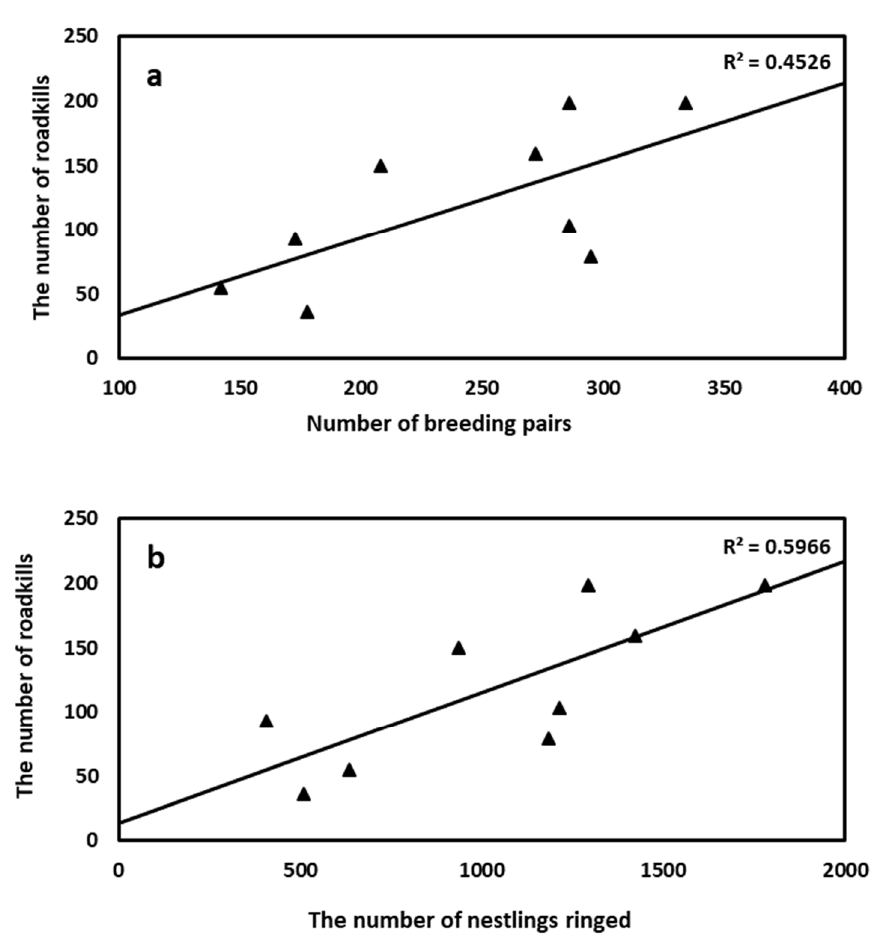
Figure 4. ( a , b ) The number of barn owl roadkills from 2009 to 2017 was positively related to the number of barn owl breeding pairs (a) and the number of nestlings ringed (b).